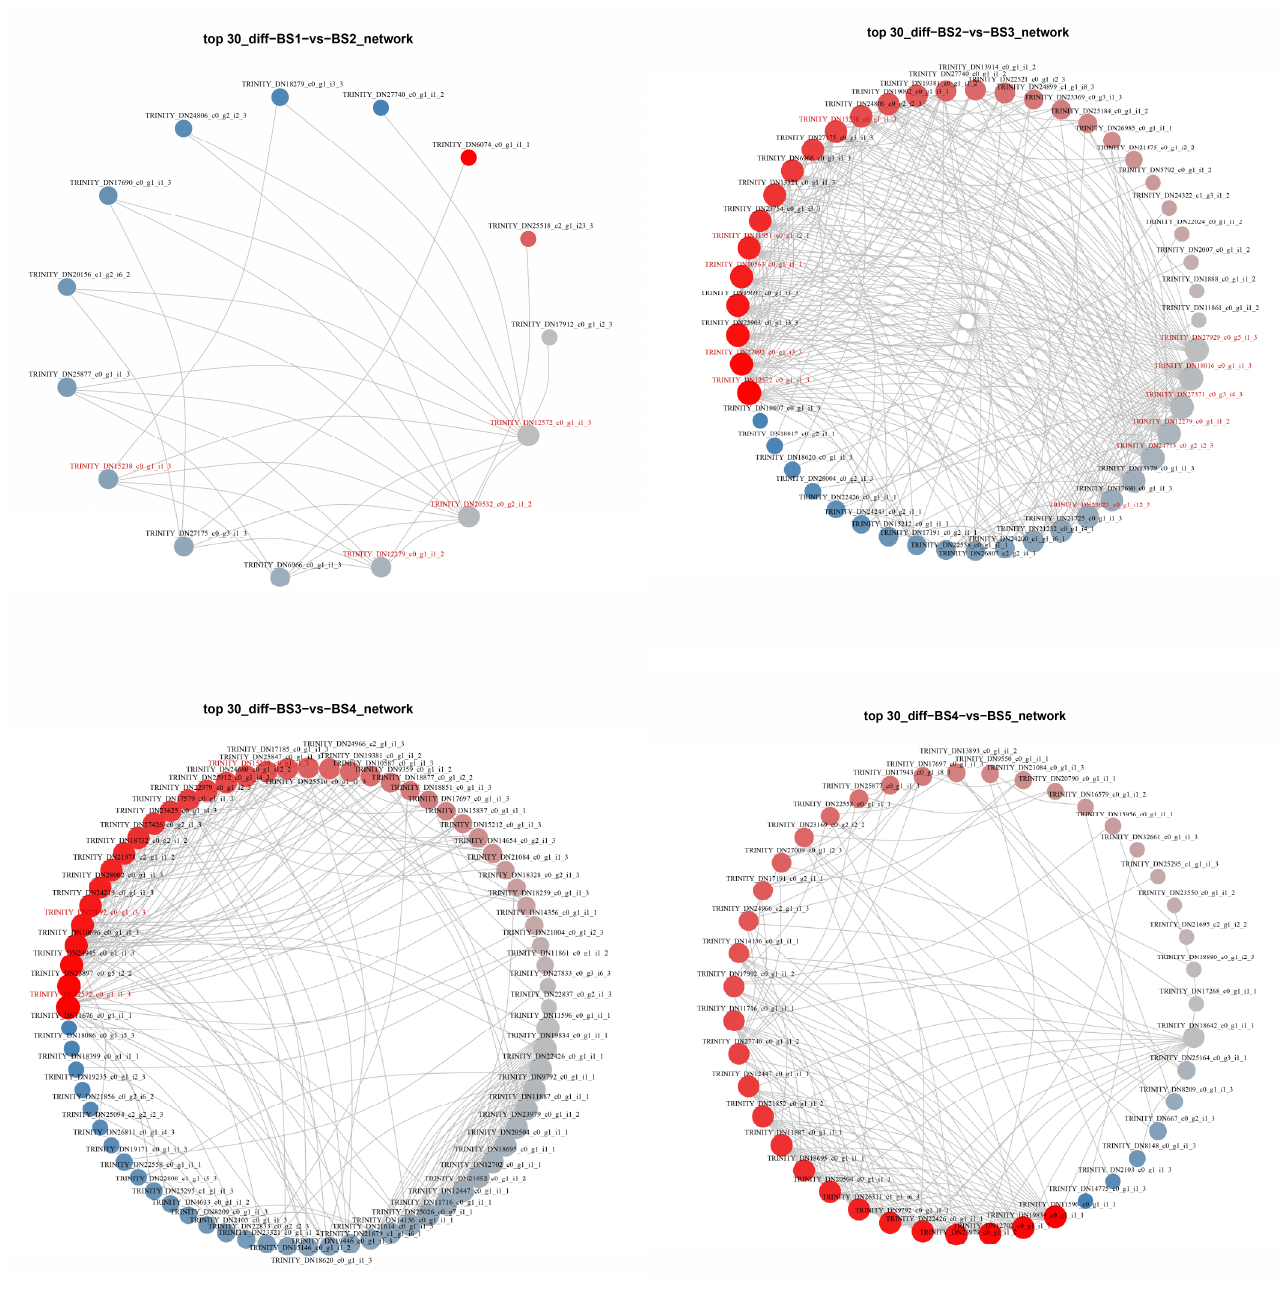
Figure 7. Protein–protein interaction network of differentially expressed genes. Red indicates differential genes with upregulated expression; blue indicates differential genes with downregulated expression, and the connecting lines between them indicate the presence of interaction between genes. The more genes that are associated, the larger the point of the gene.